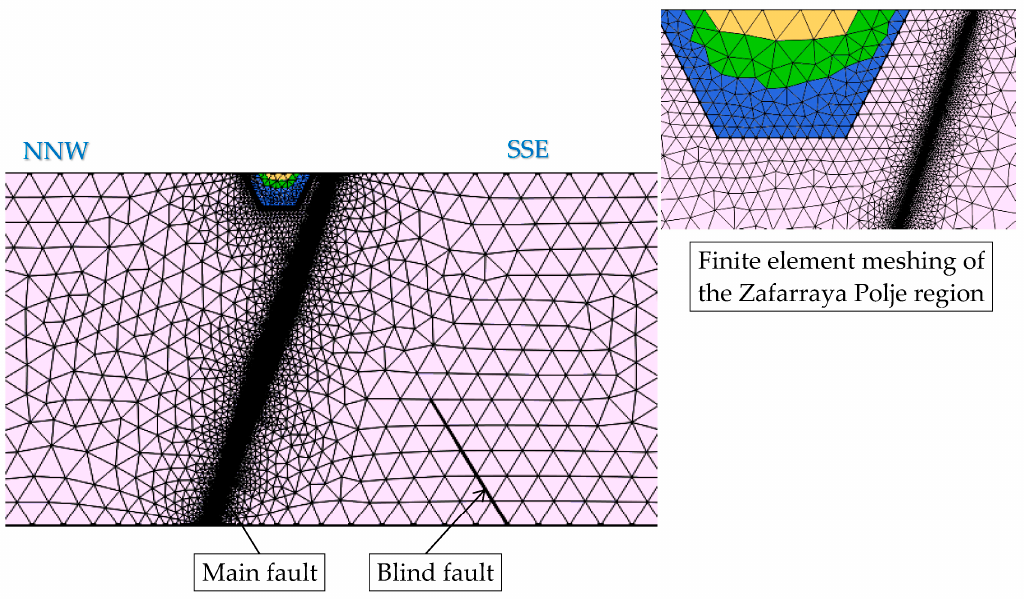
Figure 7. Discretization of the 2D finite element mesh in accordance with the scheme of Figure